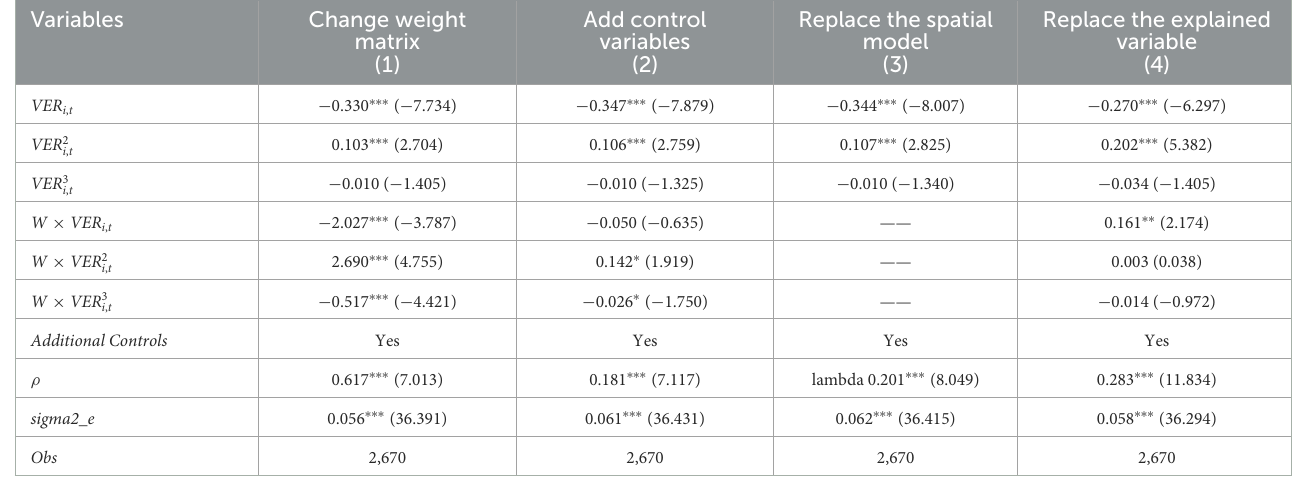
TABLE 8 The robustness test of effect of VER on GDE.